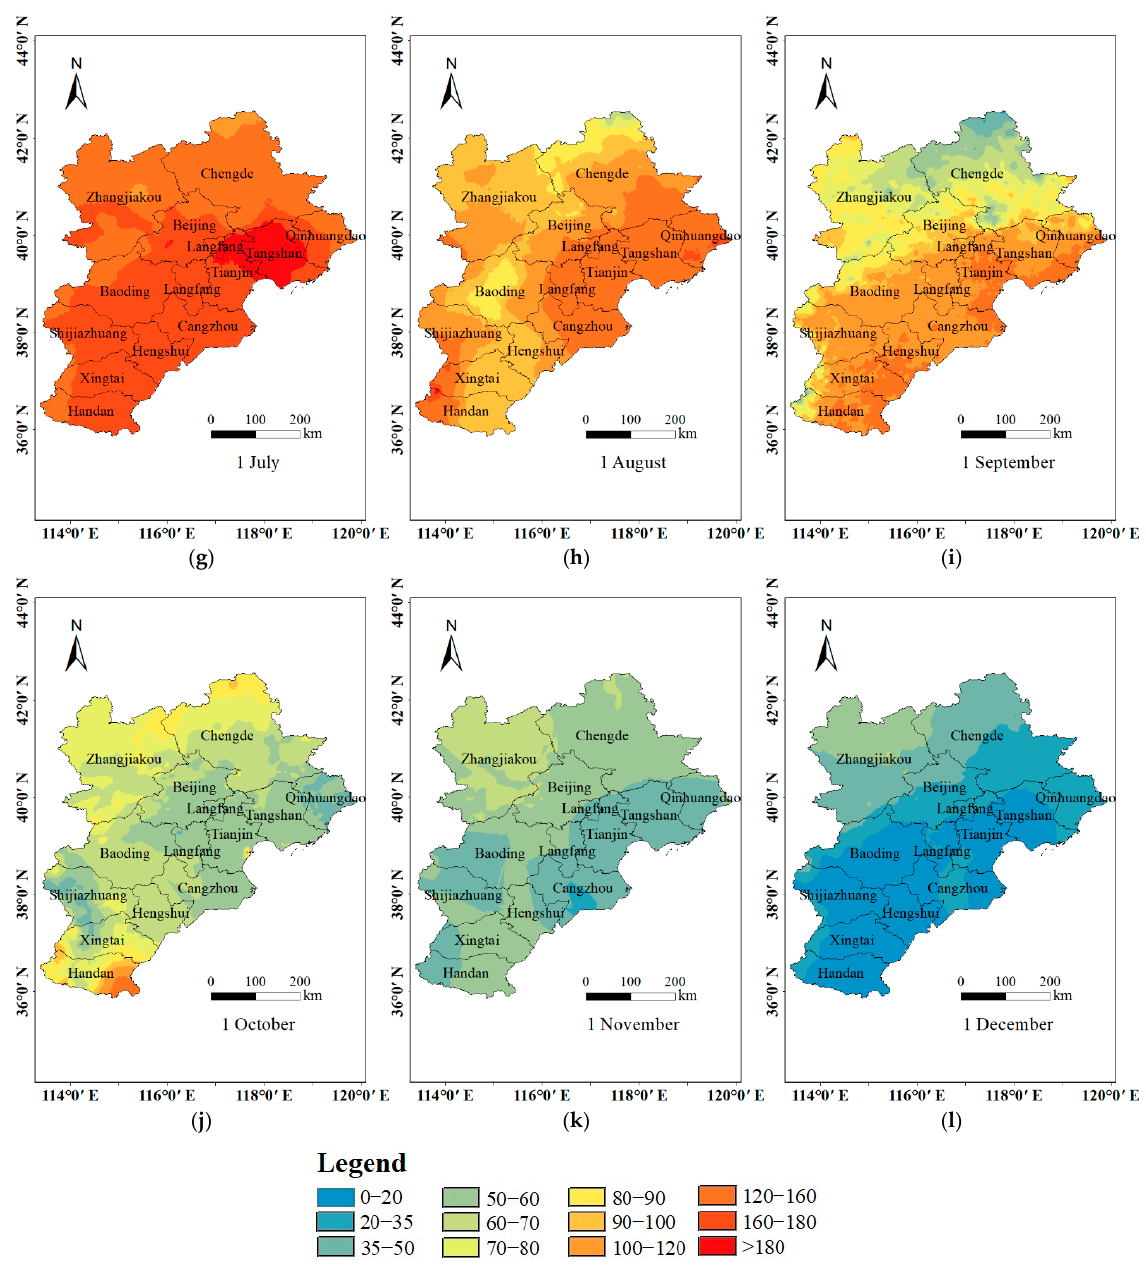
Figure 4. Short-term O 3 exposure levels based on GWR model for the first day of every month in the BTH region in 2020. ( a ) 1 January, ( b ) 1 February, ( c ) 1 March, ( d ) 1 April, ( e ) 1 May, ( f ) 1 June, ( g ) 1 July, ( h ) 1 August, ( i ) 1 September, ( j ) 1 October, ( k ) 1 November, and ( l ) 1 December, respectively. Figure 5 displayed the seasonal average O 3 concentrations and the percentages of O 3 exceedance days. The variation of O 3 concentrations showed an obvious seasonal characteristic in the BTH region. O 3 concentration was the highest in summer with an average value of 140.36 µ g/m 3 , followed by spring (109.48 µ g/m 3 ), autumn (70.24 µ g/m 3 ) and winter (51.73 µ g/m 3 ). In both spring and summer, O 3 concentrations did not meet the Class I standard of Ambient Air Quality Standards of China (100 µ g/m 3 ). From the exceedance rate of each season, it can be revealed that the percentage of O 3 exceedance days ranged from 0% to 90.22%. The percentage of O 3 exceedance days in summer was the highest, which were 87.78%, 87.36%, 85.23%, and 90.22% from 2017 to 2020, respectively, while the lowest was in winter, meeting the standard in all four